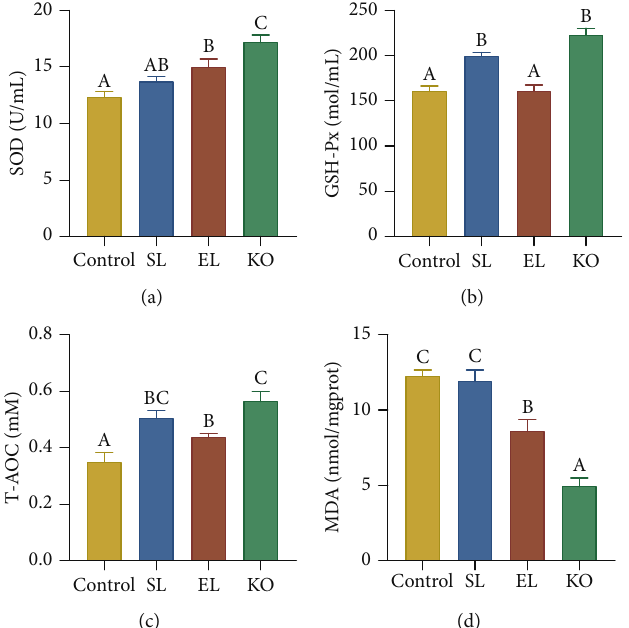
Figure 5: Antioxidant capacity of C. quadricarinatus fed four diets with di ff erent phospholipid sources for 10 weeks. (a) Superoxide dismutase activity. (b) Glutathione peroxidase activity. (c) Total antioxidant capacity. (d) Malondialdehyde content. Data are expressed as the mean ± SEM (standard error of the mean) ( n = 4 , replicate tanks). Di ff erent uppercase letters (A, B, and C) indicate signi fi cant di ff erences ( P < 0 : 05 ) ( C > B > A ). SOD = superoxide dismutase; GSH-Px = glutathione peroxidase; T-AOC = total antioxidant capacity; MDA = malondialdehyde.